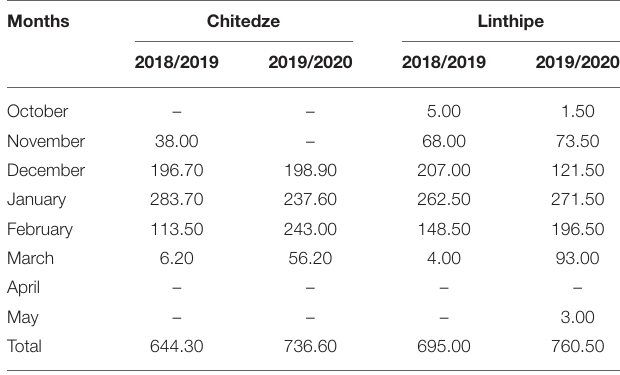
TABLE 2 | Mean soil physical and chemical properties sampled from the 0–20-cm depth at Chitedze and Linthipe experimental sites in 2018/2019 and 2019/2020 cropping